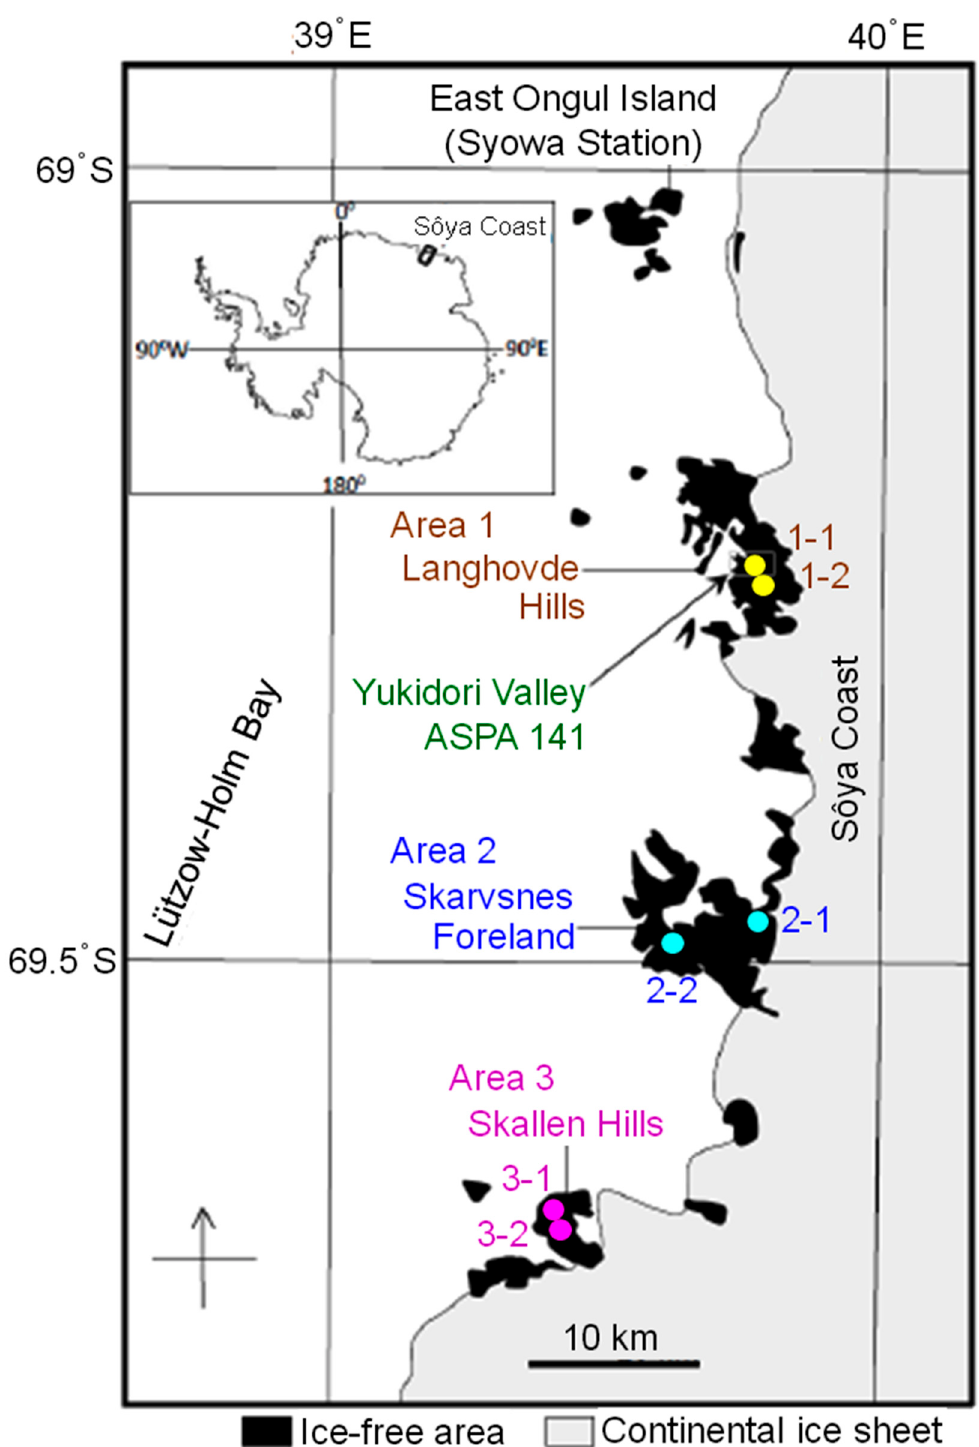
Figure 1. Location of sampling sites along the east coast (Sôya Coast) of Lützow-Holm Bay, near Syowa Station in Queen Maud Land, East Antarctica. Sites 1-1 and 1-2 are located in area 1, Langhovde Hills; sites 2-1 and 2-2 in area 2, Skarvsnes Foreland; and, sites 3-1 and 3-2 in area 3, Skallen Hills. Table 1. List of sampling sites of rock tripe lichen specimens along the east coast of Lützow-Holm Bay, Queen Maud Land, East Antarctica, and the numbers of sampled colonies. Area